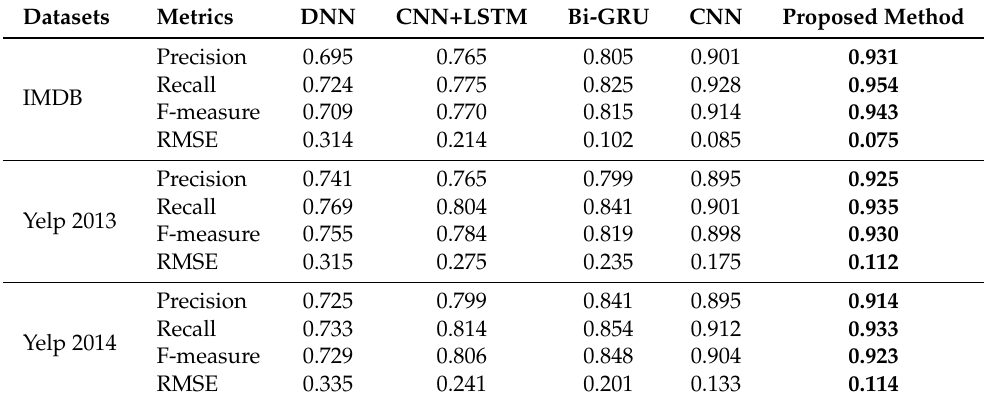
Table 3. Comparison of proposed spider Taylor-ChOA-based HAN with existing methods using based on review rating prediction, in terms of precision, recall, F-measure and RMSE. The best results are displayed in